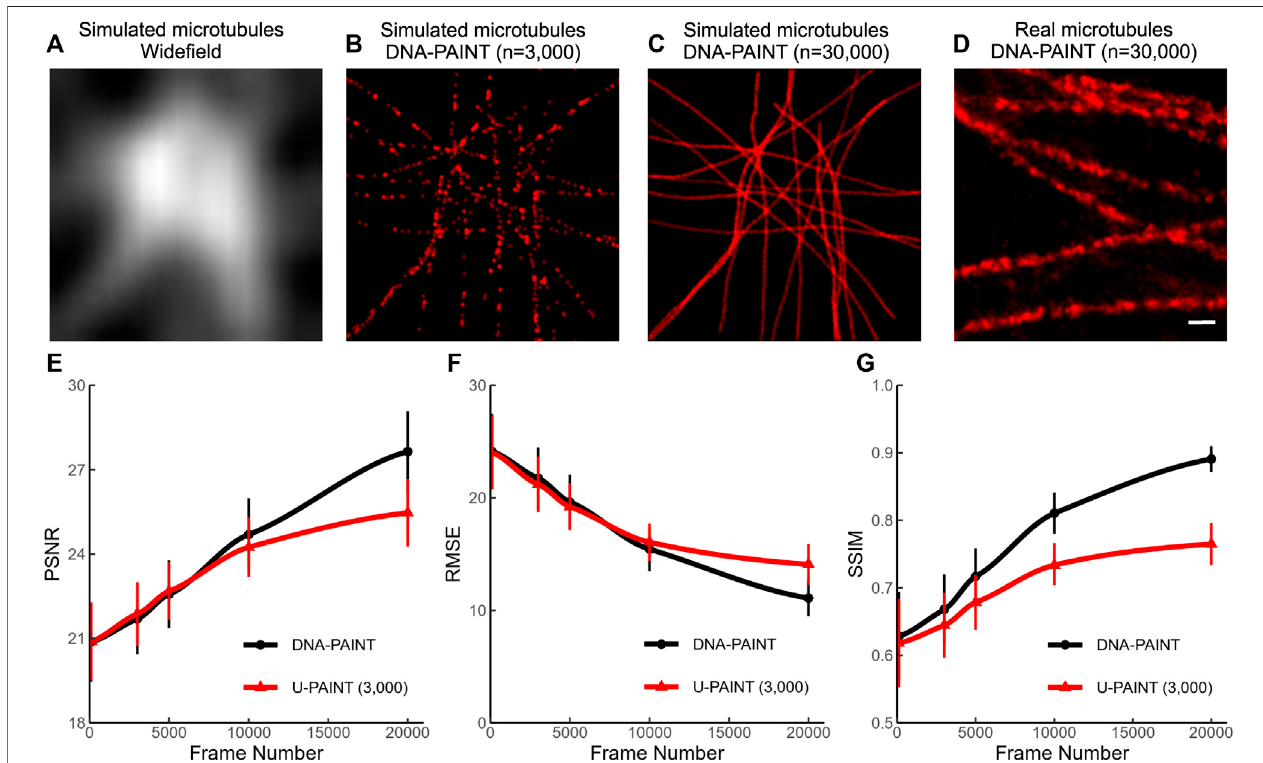
FIGURE3| Simulationofmicrotubulesandtheirreconstructionquality. (A) Wide fi eldimageofsimulatedmicrotubules. (B) SparselocalizedDNA-PAINTimage( n = 3,000) of simulated microtubules. (C) Dense localized DNA-PAINT image ( n = 30,000) ofsimulated microtubules. (D) Dense localized DNA-PAINT image( n = 30,000) of real microtubules. (E) PSNR of U-PAINT (3,000) reconstruction results and DNA-PAINT results with different frame numbers. (F) RMSE of U-PAINT (3,000) reconstruction results and DNA-PAINT results with different frame numbers. (G) SSIM of U-PAINT (3,000) reconstruction results and DNA-PAINT results with differentframenumbers.PSNR,RMSE,andSSIMaremeasuredcomparedwithresultsandgroundtruth.Redlineswithtrianglepoints:performanceofU-PAINT(3,000); black lines with circle points: performance of conventional DNA-PAINT. Dots are averages from 36 simulations; error bars show s.d. Scale bar: 200 nm. U-PAINT reconstruction of endogenous microtubules.